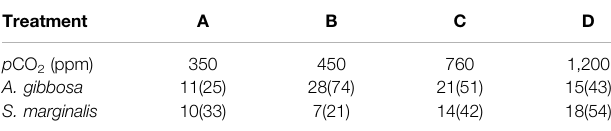
TABLE 2 | Summary of the number of specimens and ablations (in brackets) per species per condition (Treatment A, B, C and D) analyzed by LA-Q-ICP-MS.